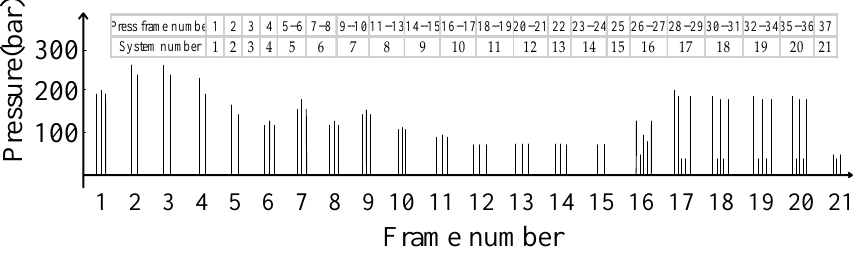
Figure 1. Medium-density fiberboard (MDF) hot pressing pressure trend